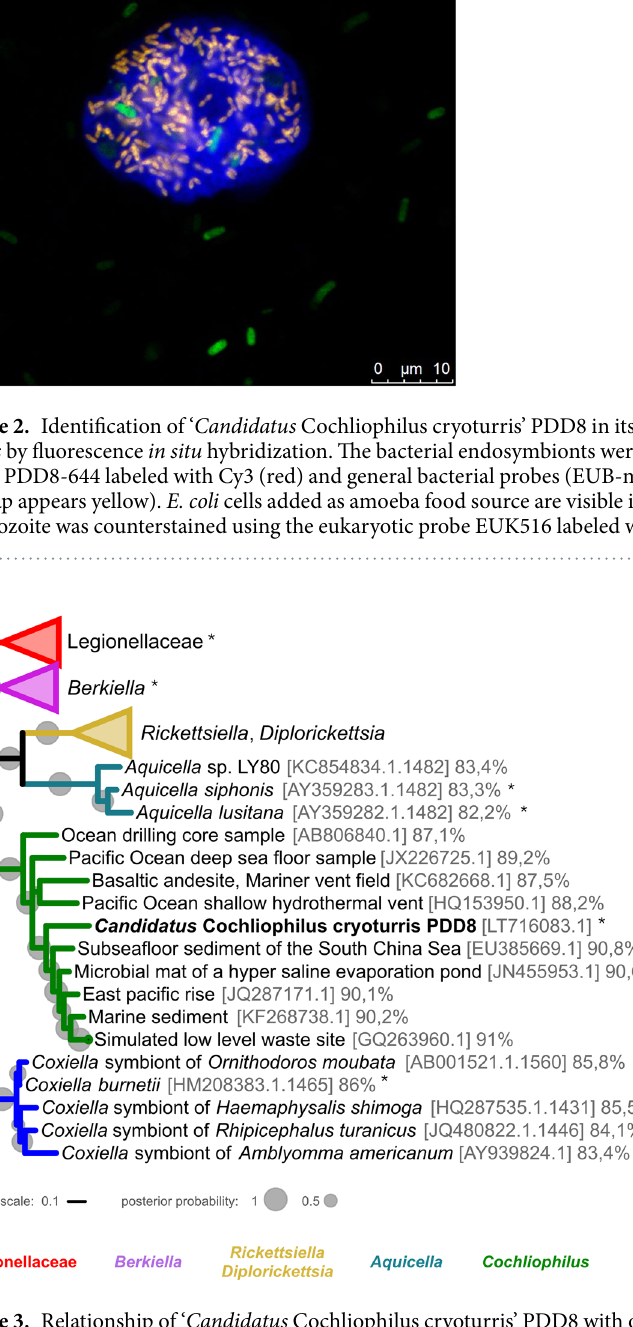
Figure 3. Relationship of ‘ Candidatus Cochliophilus cryoturris’ PDD8 with other members of the Legionellales. A 16S rRNA tree based on PhyloBayes using the CAT model and GTR exchange rates is shown. Posterior probability values are indicated as grey circles at the nodes. Accession numbers and sequence similarity values to C. cryoturris are provided. Taxa with reported amoeba association are labeled with an asterisk. C. cryoturris together with a number of sequences obtained from various aquatic samples forms a novel sister clade of the Rickettsiella/Diplorickettsiella/Aquicella group in the family